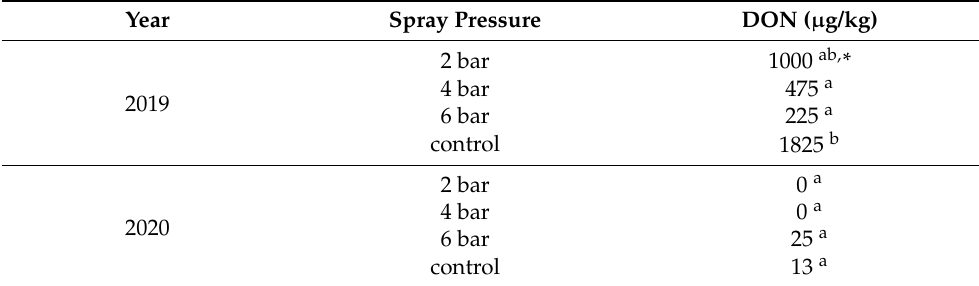
Table 5. Deoxynivalenol (DON) content in the grain ( µ g/kg).